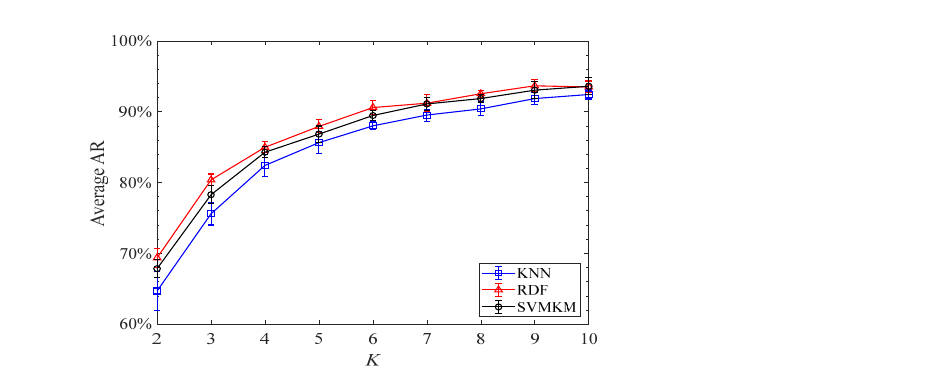
Figure 9. The average recognition AR of 11 species by using three intelligent classifiers. Error bar is the standard deviation of the result under 10 independent realizations.